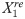
The architecture of the TRHD-CNN model.Given an account v, the feature matrices Tv and Wv are input to the model through different routes. Features in Tv are mapped into vector X1re by Process 1 and those in Wv are mapped into X2re through Process 2 similarly. Being concatenated into Xmer, the features from X1re and X2re are compressed into a shorter vector Xfu by a fully connected layer. The output layer can be seen as a classifier that maps the features of Xfu into two category labels.